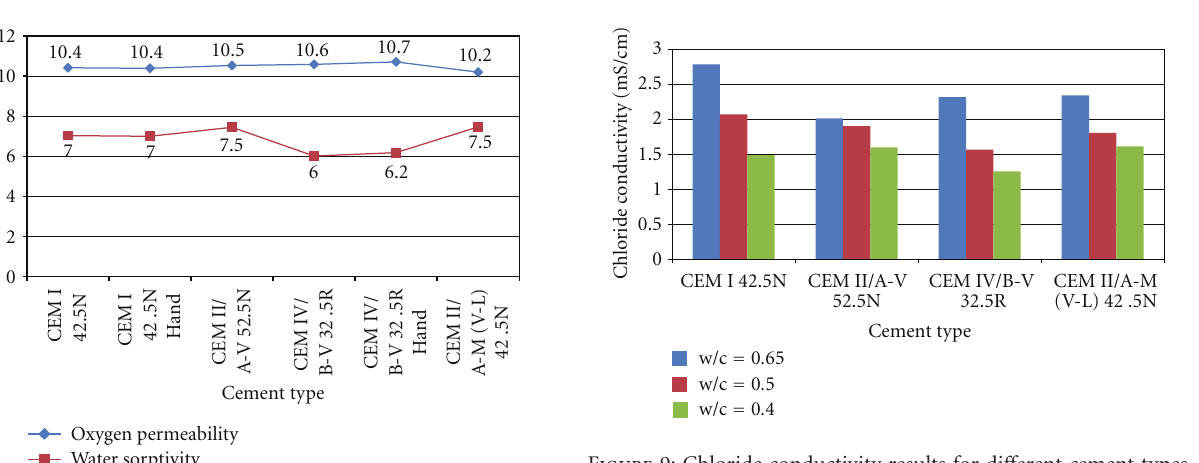
Figure 9: Chloride conductivity results for di ff erent cement types and concretes of normal, medium, and high